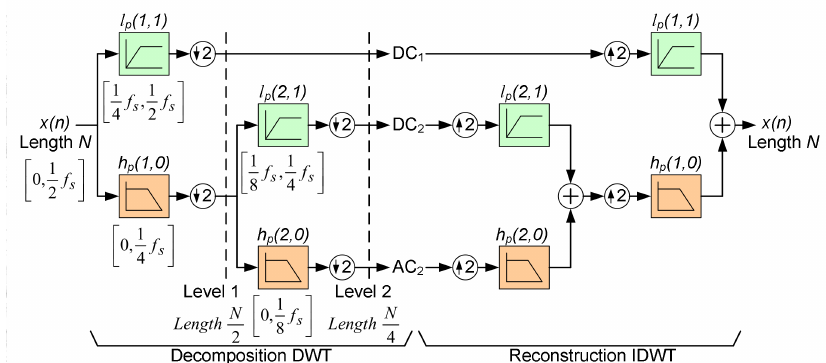
Figure 1. Graphical description of the wavelet-transform reconstruction and decomposition utilizing the Mallat